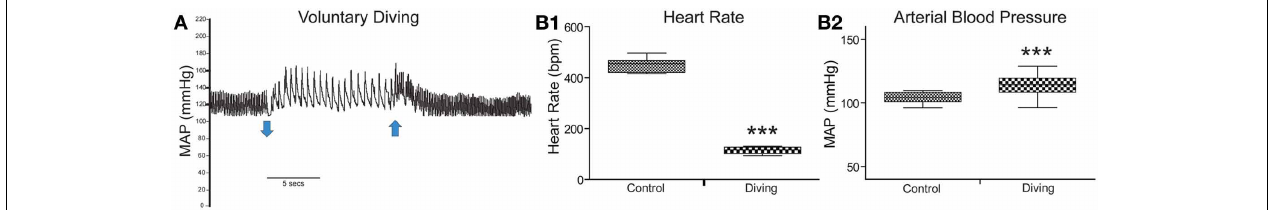
arrow). Compilation of trials ( n = 24) from eight rats showing the 80% drop in heart rate ( B1 ; HR, p < 0 . 001) and increase in MAP ( B2 , p < 0 . 001) after